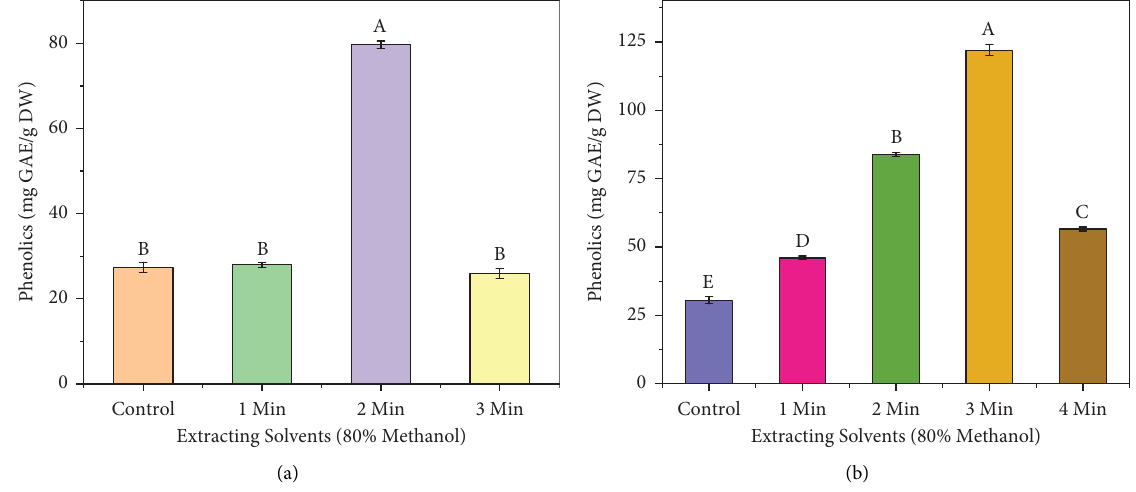
Figure 21: Estimation of phenolics content in untreated and plasma treated seeds of (a) radish and (b)